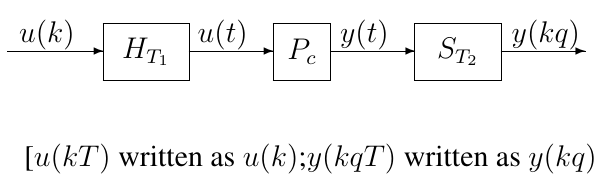
Figure 1. The dual-rate Hammerstein